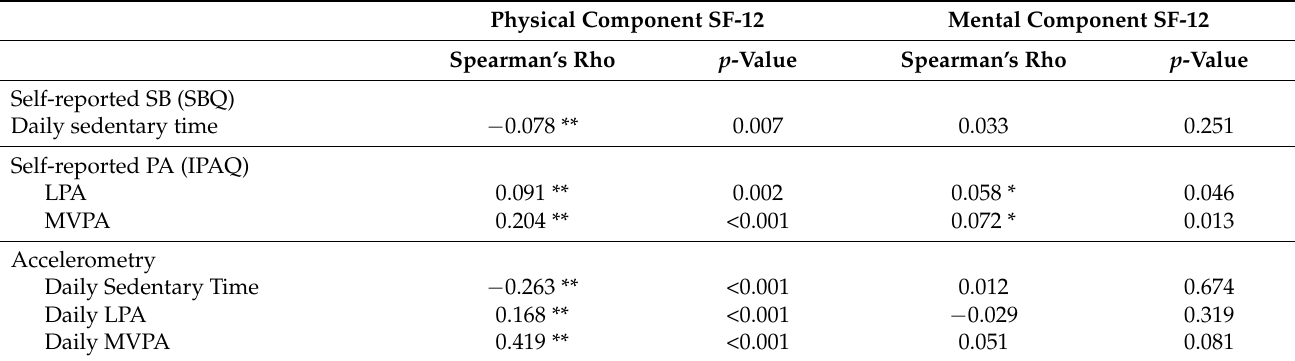
Table 2. Relationship between self-reported and device-measured SB and PA, and the physical and mental component scores of the SF-12 (HRQoL). Spearman’s Rho coefficients and p